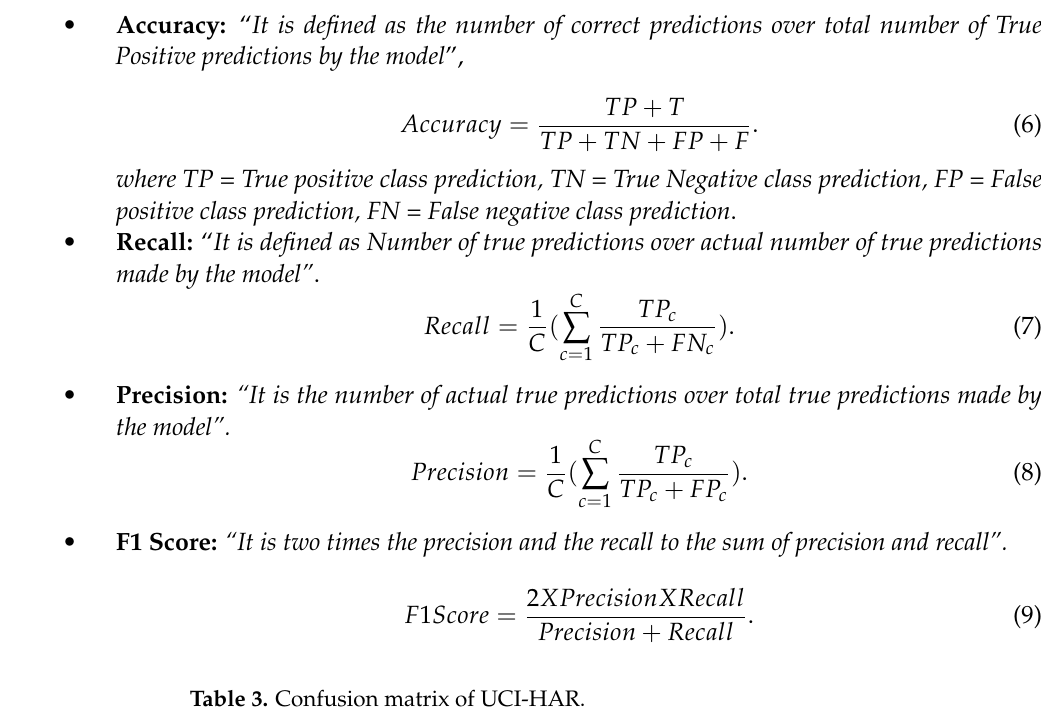
Table 3. Confusion matrix of